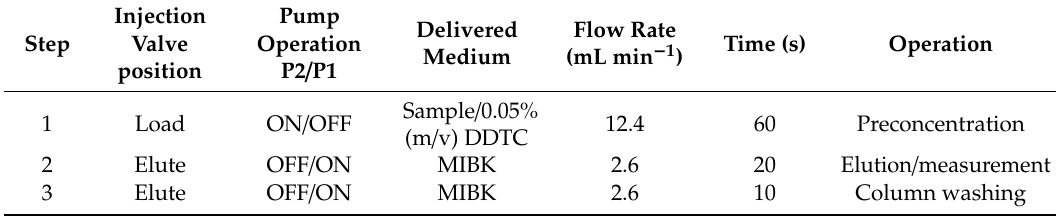
Table 1. Operational sequences of the developed on-line FI–SPE–FAAS method for thallium